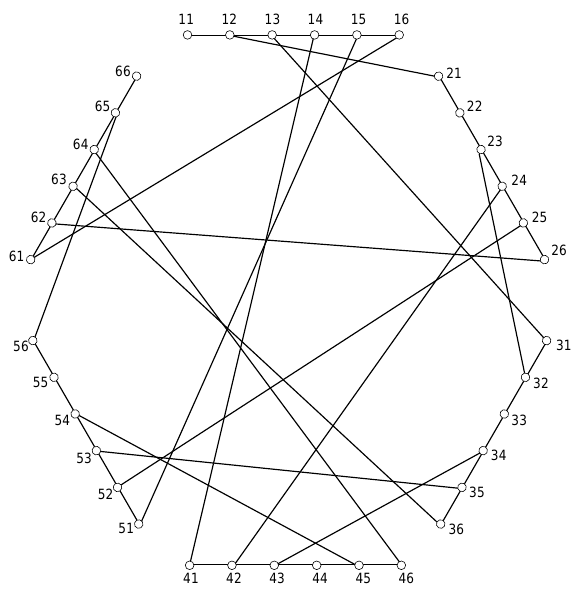
6 . Using formula (1) P n